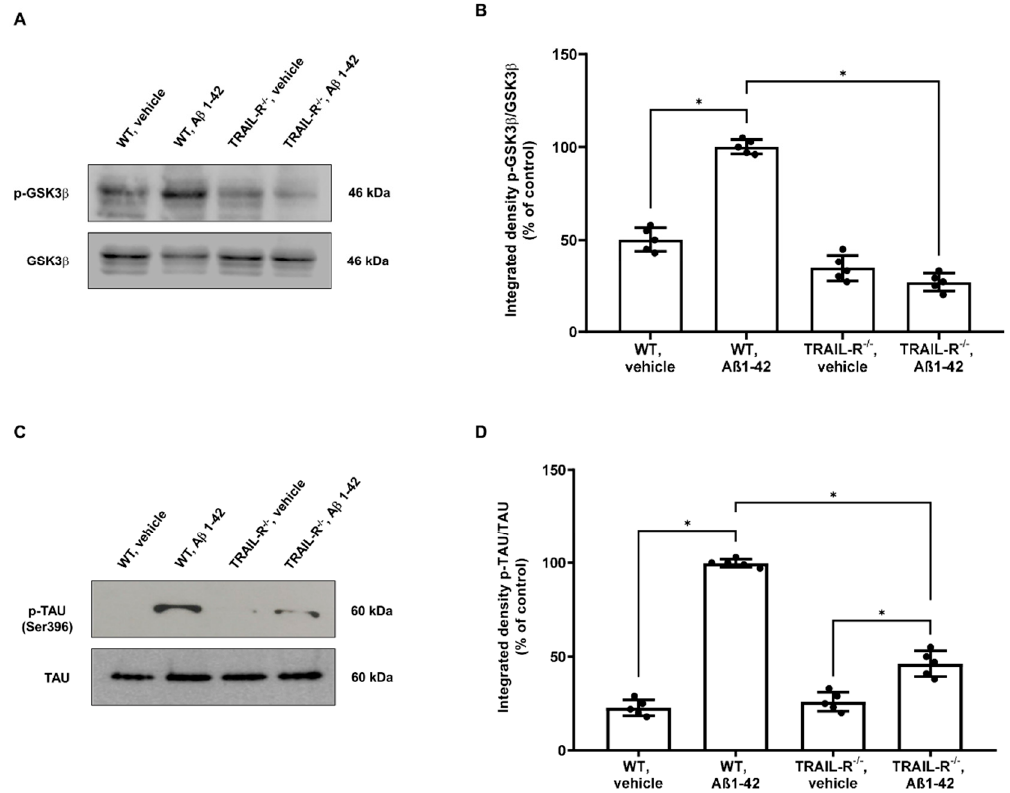
Figure 6. Phosphorylation of GSK3 β and Tau is attenuated in TRAIL-R − / − mice treated with oligomeric A β 1-42. Western blot analysis of ( A ) p-GSK3 β and ( C ) p-Tau in WT and TRAIL-R − / −